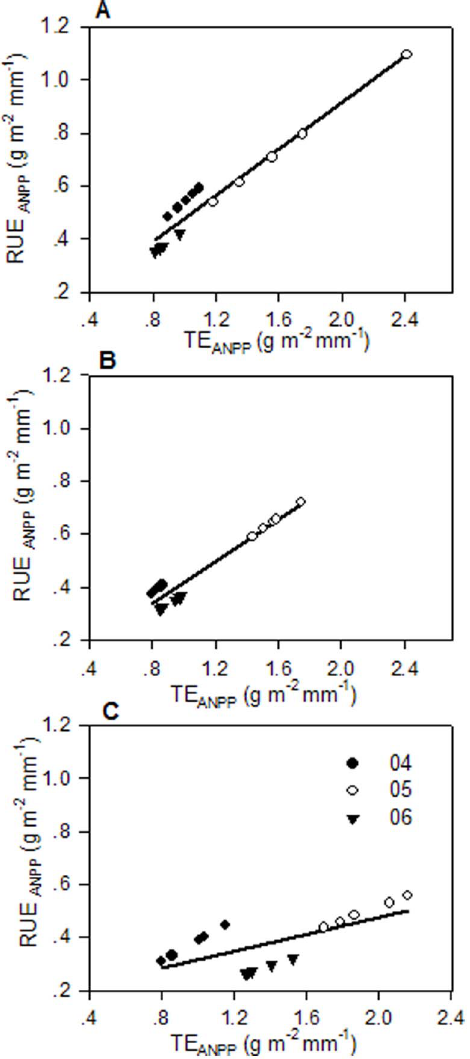
Table 5. Transpiration efficiency (TE, g m 2 2 mm 2 1 ) based on aboveground-(ANPP) and net primary productivity (NPP) of the three grassland sites in 2004, 2005 and 2006.